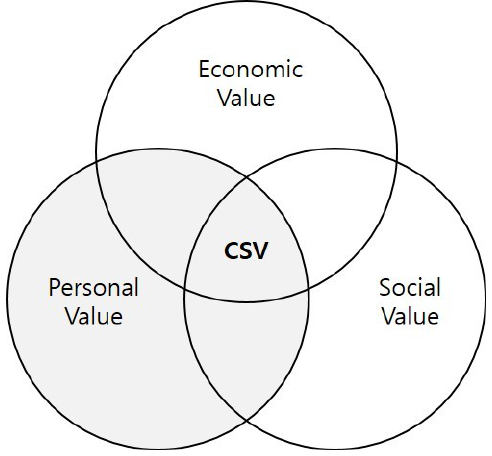
Figure 1. Areas of Personal Value in Creating Shared Value (CSV).